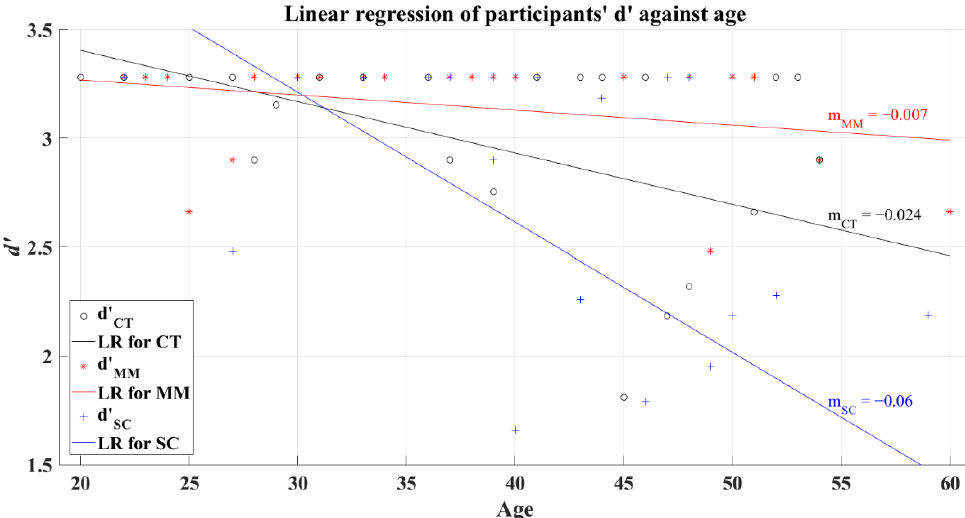
Figure 6. Linear regression of participants’ average d’ versus age for 2AFC-P1. Black line—linear regression for Control group (LR for CT); red line—linear regression for Mild-Moderate post-COVID group (LR for MM); blue line—linear regression for Severe-Critical post-COVID group (LR for SC); d (cid:48) , Control group’s efficiency index; d (cid:48) , Mild-Moderate group’s efficiency index; d (cid:48) MM CT Critical group’s efficiency index; m CT , Control group’s slope; m MM , Mild-Moderate group’s slope; m SC , Severe-Critical group’s